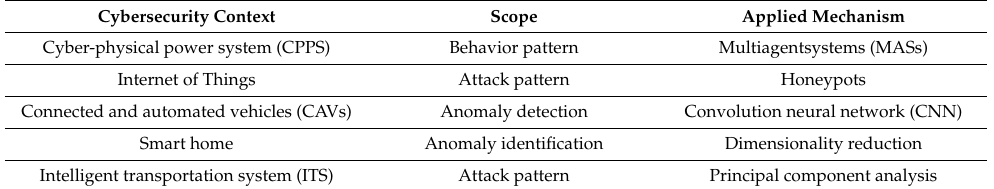
Table 9. Topics related to anomalies.